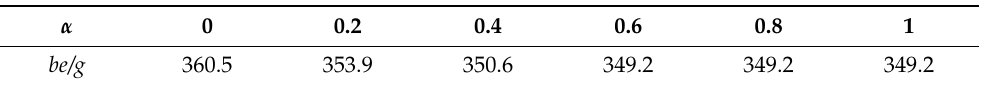
Table 12. Average specific fuel consumption corresponding to the compensable coefficient of different motors under working condition B in the bench